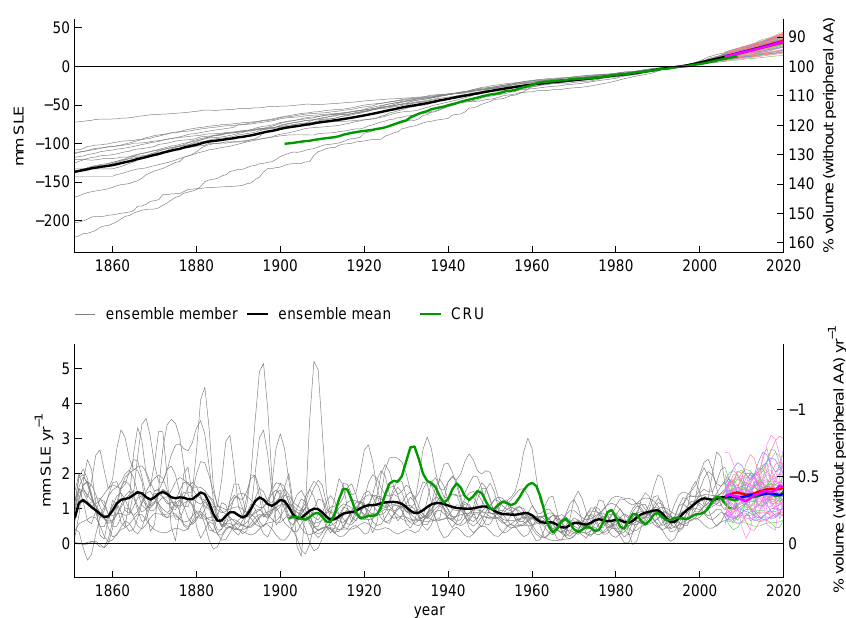
Fig. 20. Cumulative global surface mass balances relative to the 1986–2005 mean (upper panel), and rates (lower panel) from the model forced with historical CMIP5 simulations. Gray lines: model forced by individual CMIP5 ensemble members, black line: mean of gray lines, green line: results from CRU-forced model. Rates have been filtered with a 5yr low pass filter for clarity. Colors after the year 2005 indicate RCP scenarios, see Fig.